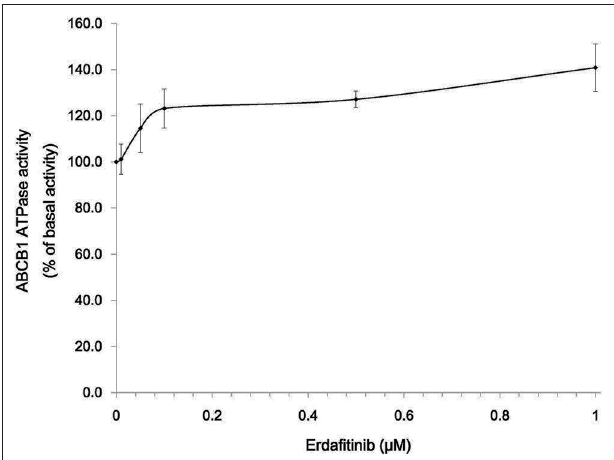
FIGURE 4 | Erdafitinib increased the ATPase of ABCB1. Data are expressed as mean ± SD. The results are representative of three independent experiments. Error bars indicate